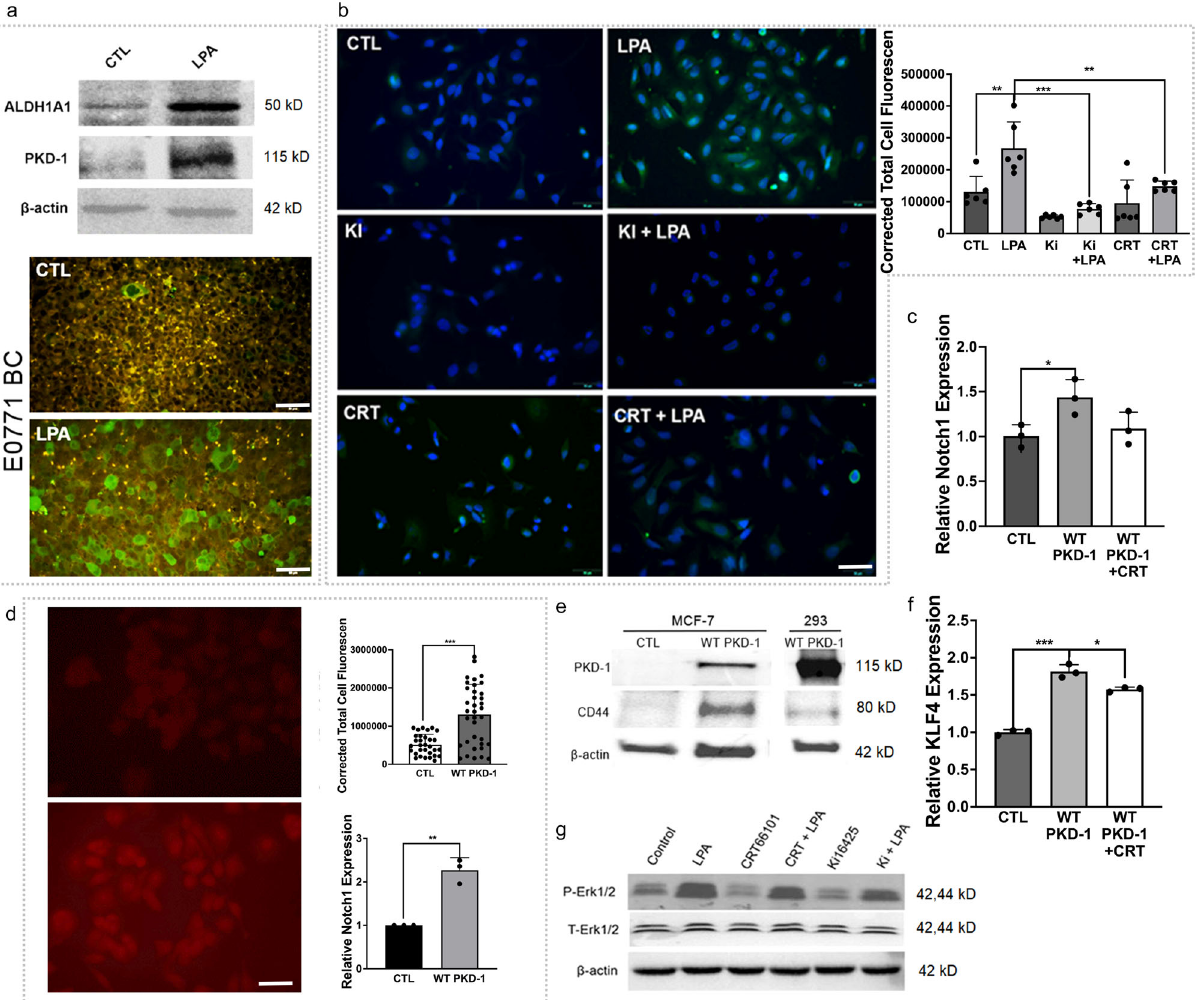
Fig. 7 LPA-PKD-1 signaling pathway in self-renewal and plasticity of breast cancer stem cells. a Induction of ALDH1A1 expression in BC cells (upper panel). The E0771 cell was cultured in RPMI-1640 medium with 10% FBS and 1% penicillin/streptomycin. The following starvation in serum-free medium for 6 h, the cells were treated with LPA (10 μ M) for 24 h, the cell lysates were collected for Western Blot. Duplicated experiments were performed, and shown is a representative result; ALDH1A1 expression in implanted E0771 BC (lower panel). Immuno fl uorescence microscopy was used to detect ALDH1A1 + BC cells in tumor tissues. Representative images are shown. Scale bar = 50 µ m. b MCF-7 cells were exposed to 10 µ m LPA, 1 µ m CRT0066101 (PKD inhibitor), 1 µ m Ki16425 (LPA 1,3 antagonist), and their combinations for 24 h. The control and treated MCF-7 cells were incubated with ALDH1A1